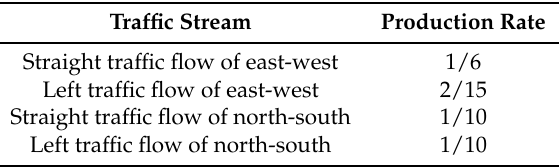
Table 2. The production rate on different directions.